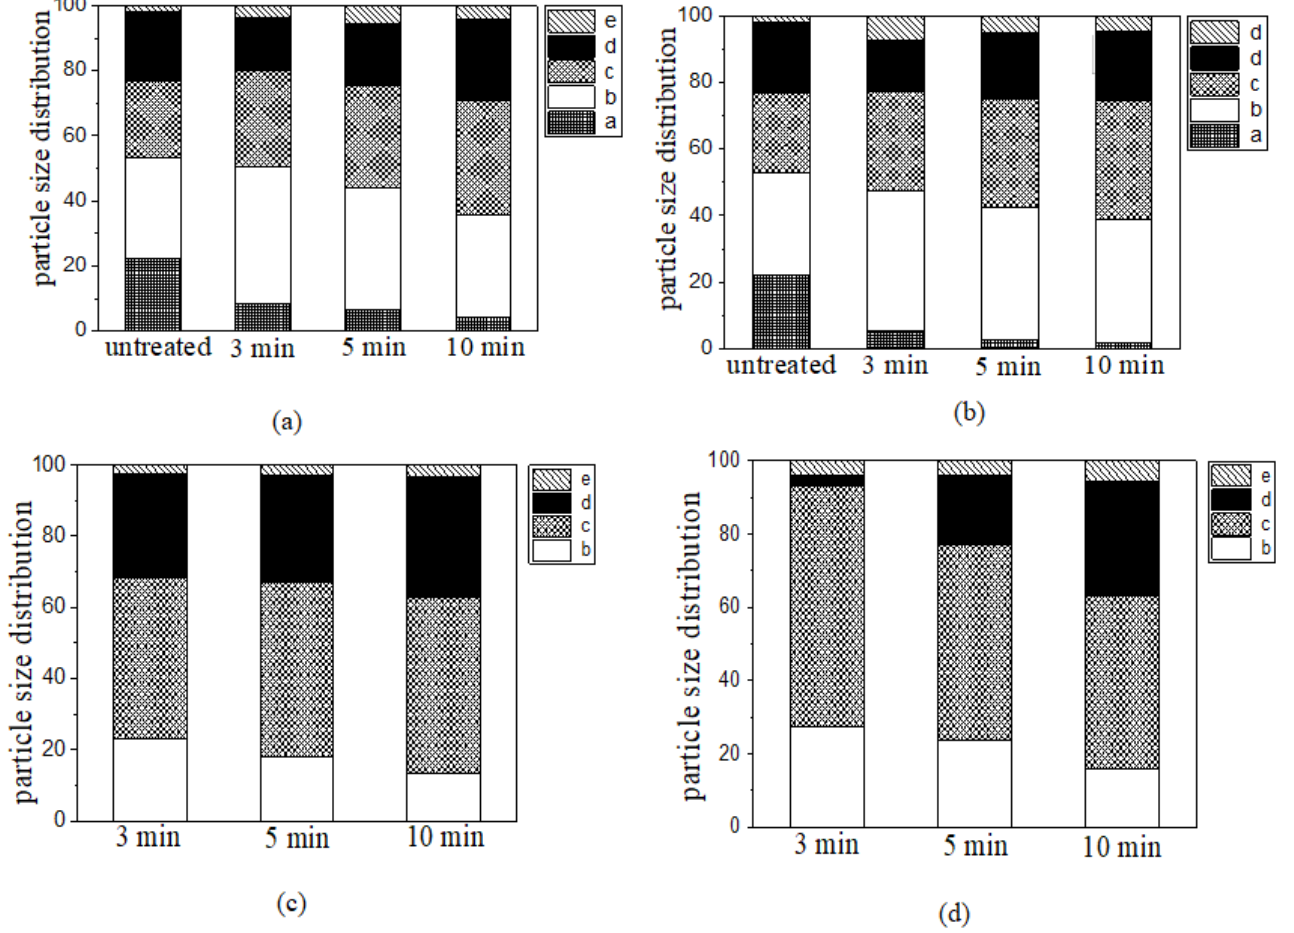
Figure 3. Particle size distributions obtained by ( a ) steel bar grinding and ( b ) steel ball grinding with ( c , d ) different times (a: >2 mm, b: 0.425–2 mm, c: 0.15–0.425 mm, d: 0.08–0.15 mm, e:<0.08 mm).